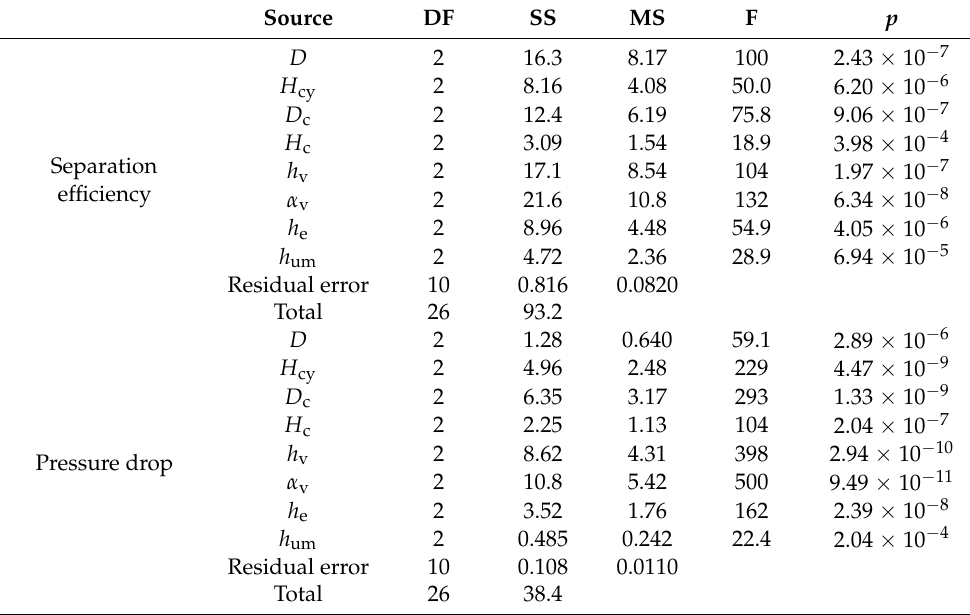
Table 7. Analysis of variance (ANOVA) for factors on SNR of separation efficiency and pressure